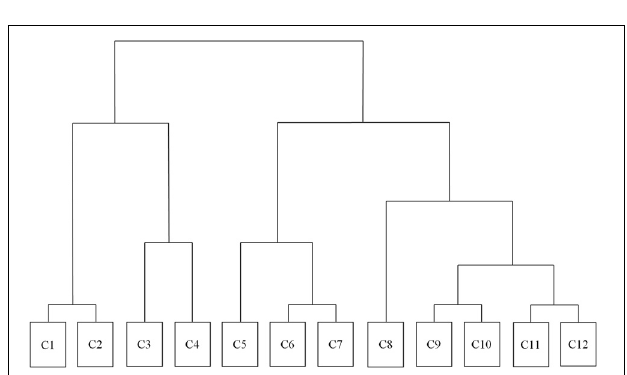
FIGURE 3 | Dendrogram of hierarchical cluster analysis. Each cluster has been given a cluster number (e.g., C1,C2). The words inside each cluster can be found in Supplementary